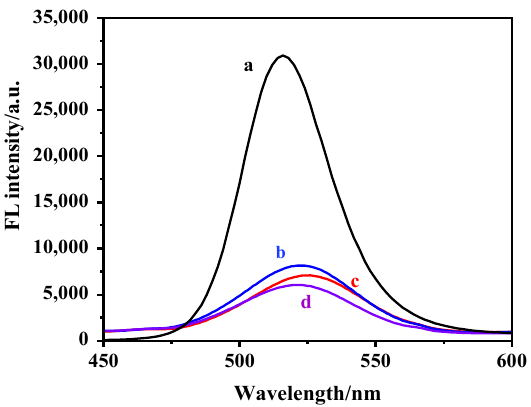
Figure 4. Fluorescence spectra of the CdTe QDs ( a ), MIP@SiO 2 @QDs ( b ), NIP@SiO 2 @QDs ( c ) and MIP@SiO 2 @CAP ( d ) (the added concentration of CAP in MIP@SiO 2 @CAP was 50.00 μ mol·L − 1 ).